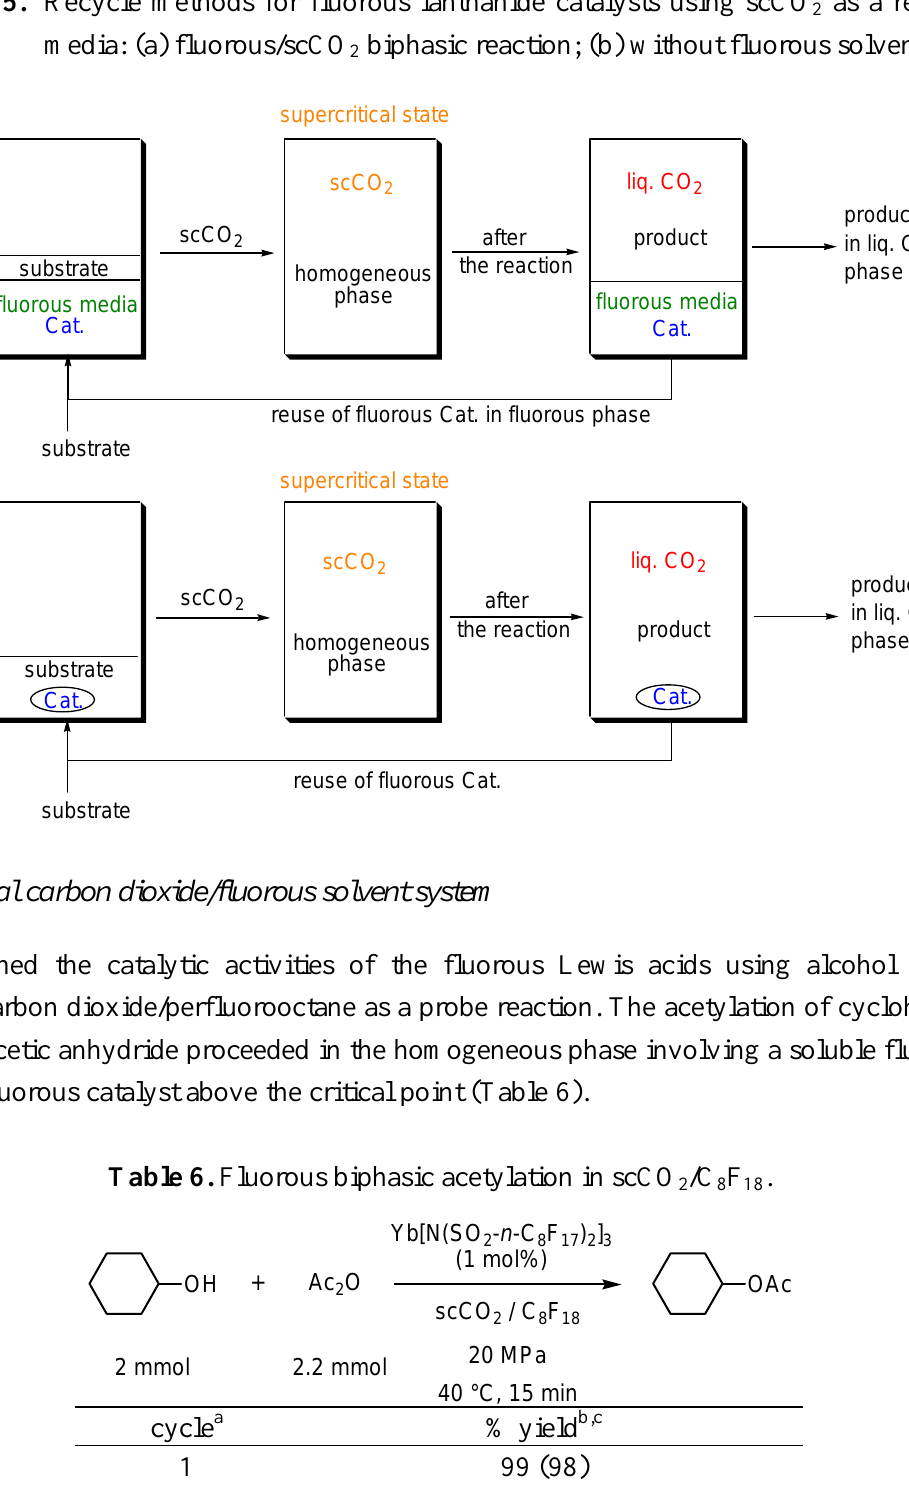
Figure 5. Recycle methods for fluorous lanthanide catalysts using scCO